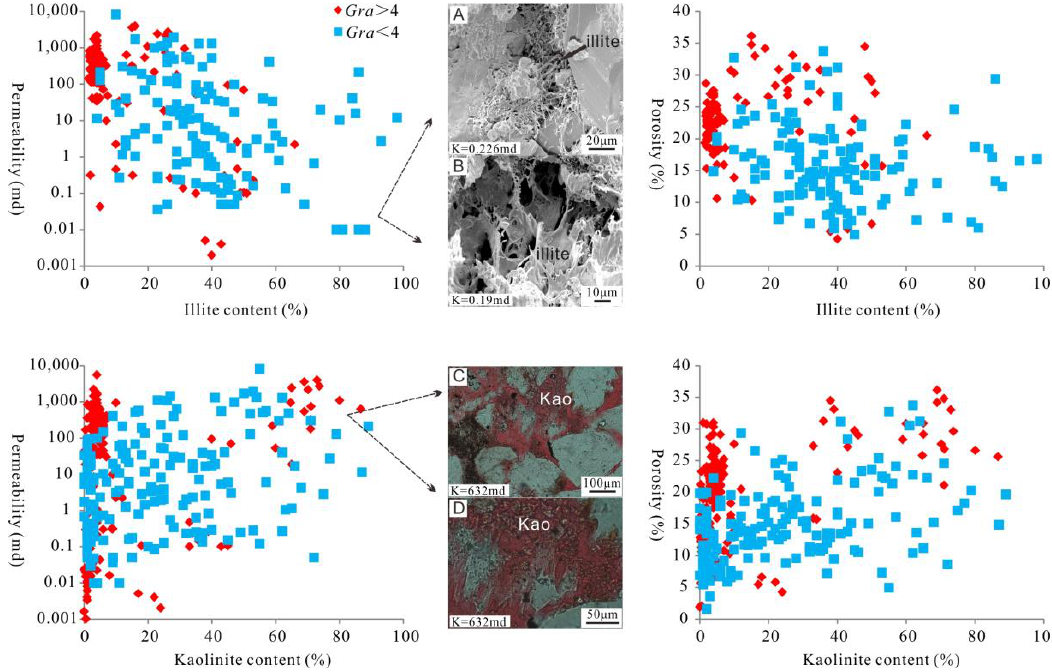
Figure 10. The relationships between clay minerals contents (illite and kaolinite) and reservoir quality.